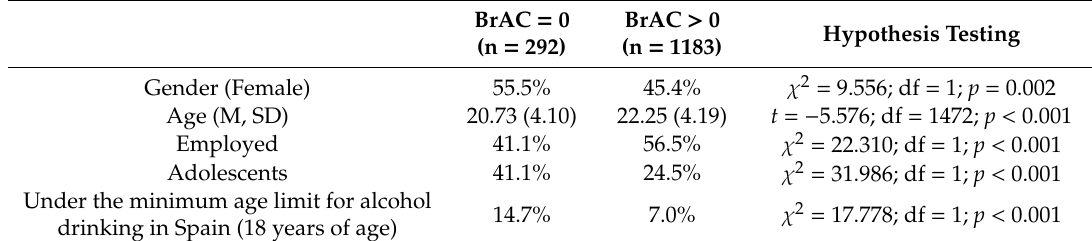
Table 3. Comparison of people with BrAC = 0 and people with BrAC > 0 in terms of Individual